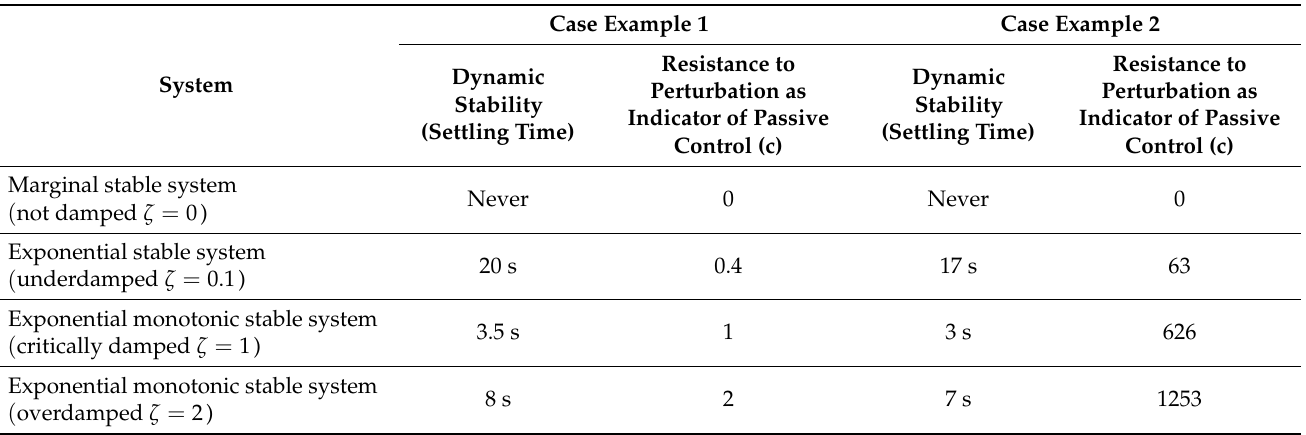
Table 6. Dynamic stability as a measure of engineering resilience for impulse input disturbance ( δ (t)) (Case examples 1 and